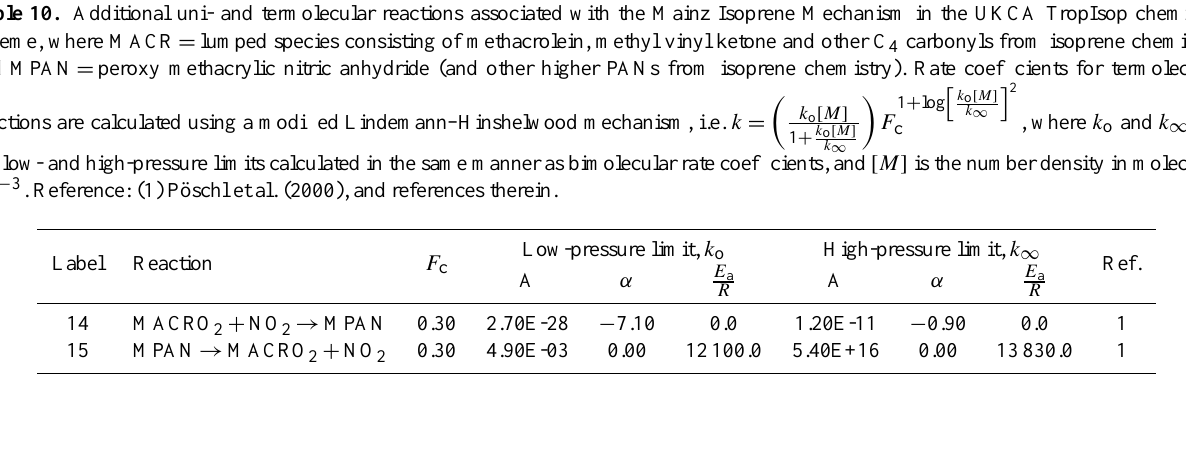
1 (cid:18) (cid:19) 1 + log k o [ M ] F c , where k o and k ∞ are 1 + k o [ M ] k ∞